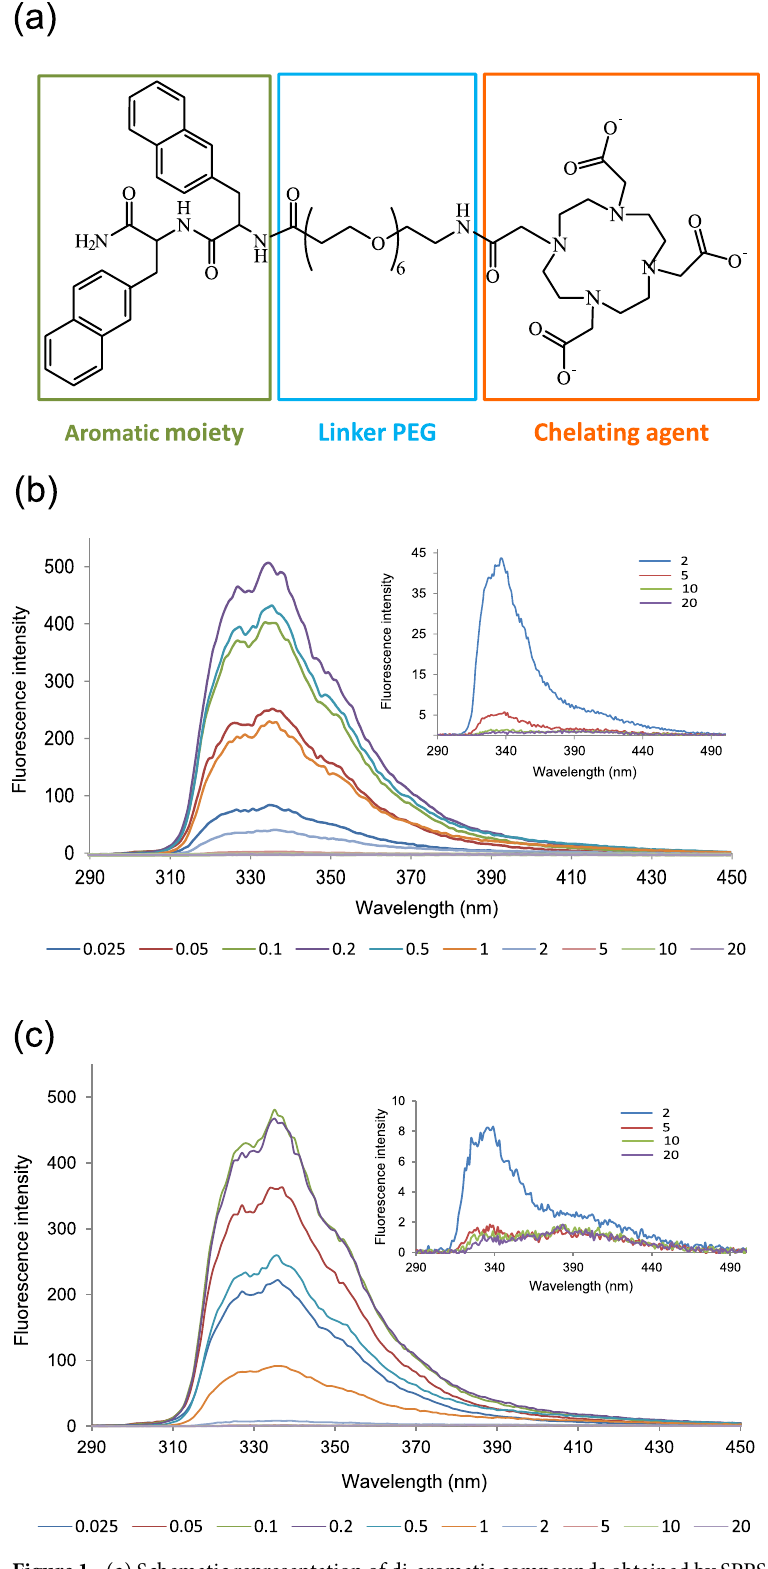
Figure 1. ( a ) Schematic representation of di-aromatic compounds obtained by SPPS with Fmoc chemistry. Conjugates contain an aromatic framework consisting of two 2-naphthylalanine (2-Nal) residues, an ethoxylic linker (L 6 ) formed by six PEG units and bifunctional and macrociclic chelating agent (DOTA) for gadolinum (III) coordination. ( b and c ) Fluorescence spectra of 2Nal 2 and Gd-2Nal 2 in 0.025–20.0 mg/mL concentration range. Samples were excited at λ = 280 nm and recorded between 290 and 500